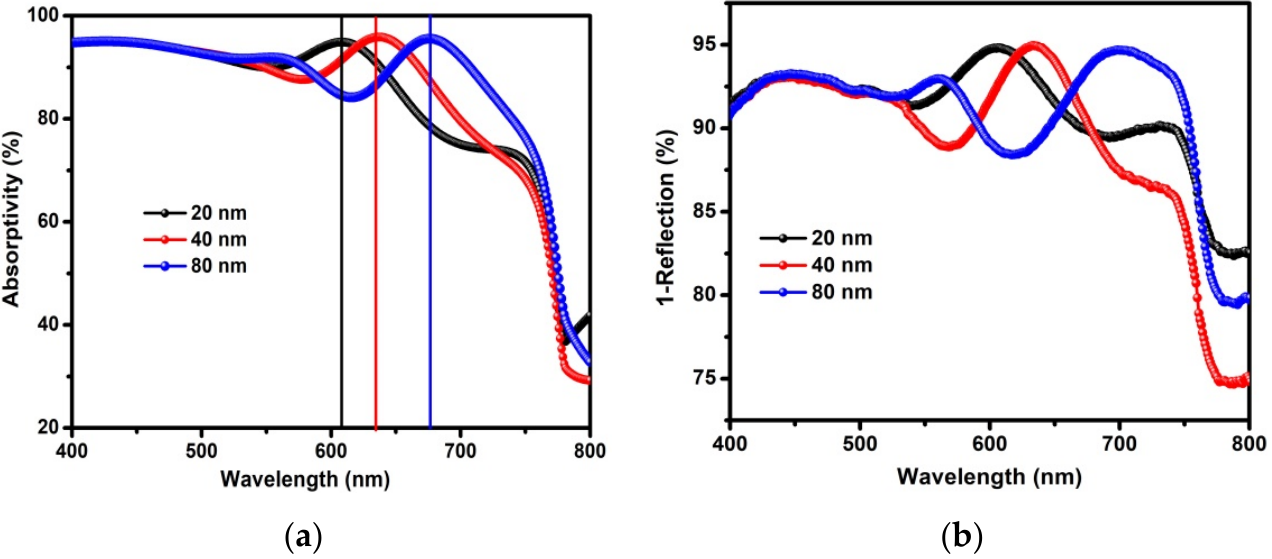
Figure 2. ( a ) The absorption of the 1 M device with different thickness (20 nm, 40 nm, 80 nm) of C 60 ETL calculated by optical simulation. ( b ) Measured 1-reflection spectra for the 1 M device with different thickness of C 60 ETL.